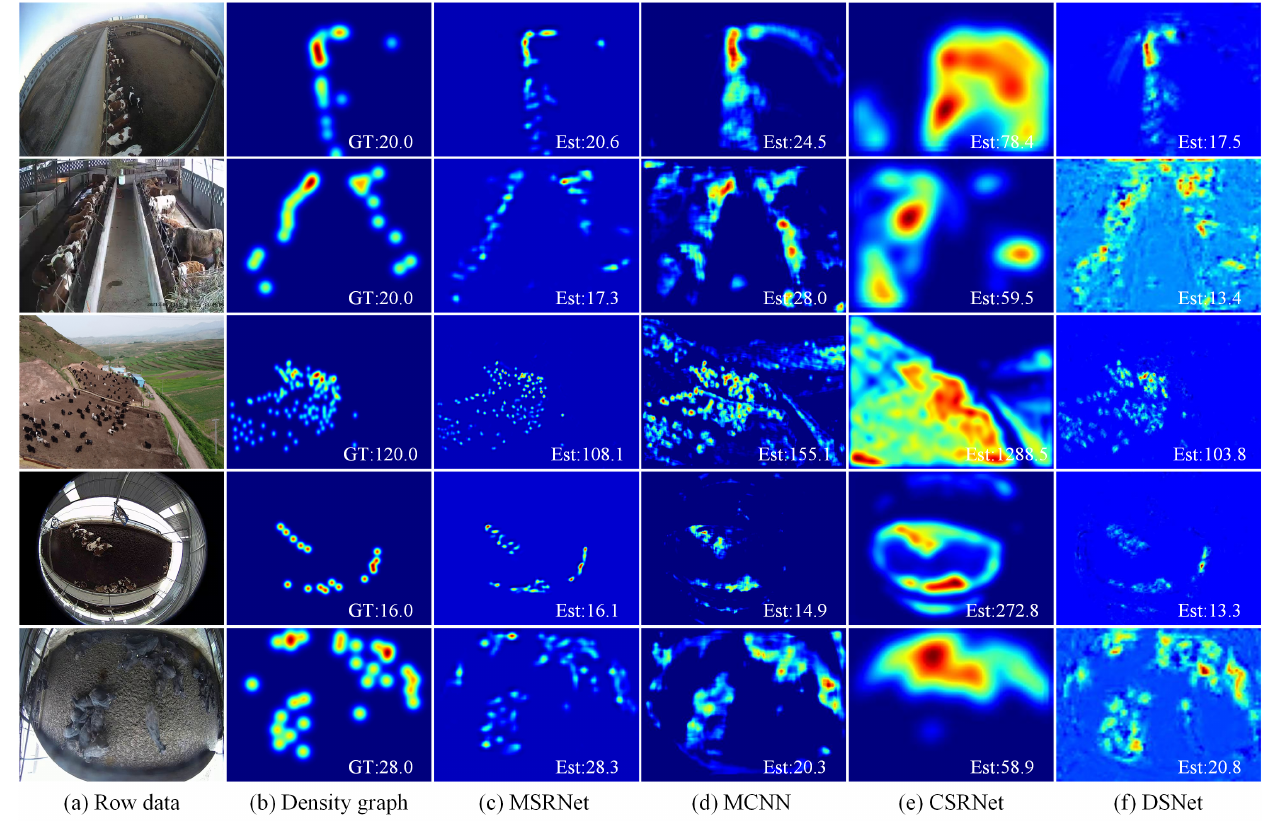
Figure 7. Density prediction results of different